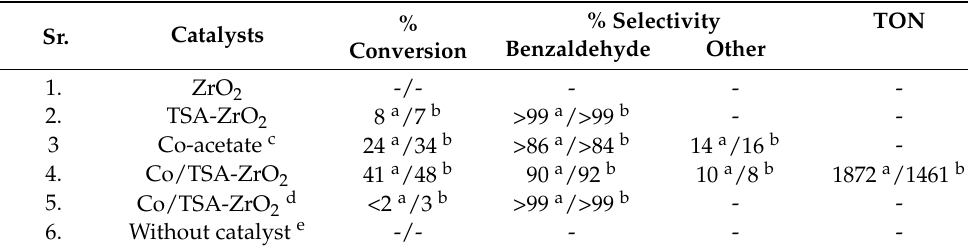
Table 1. Control experiments and effect of HPAs.